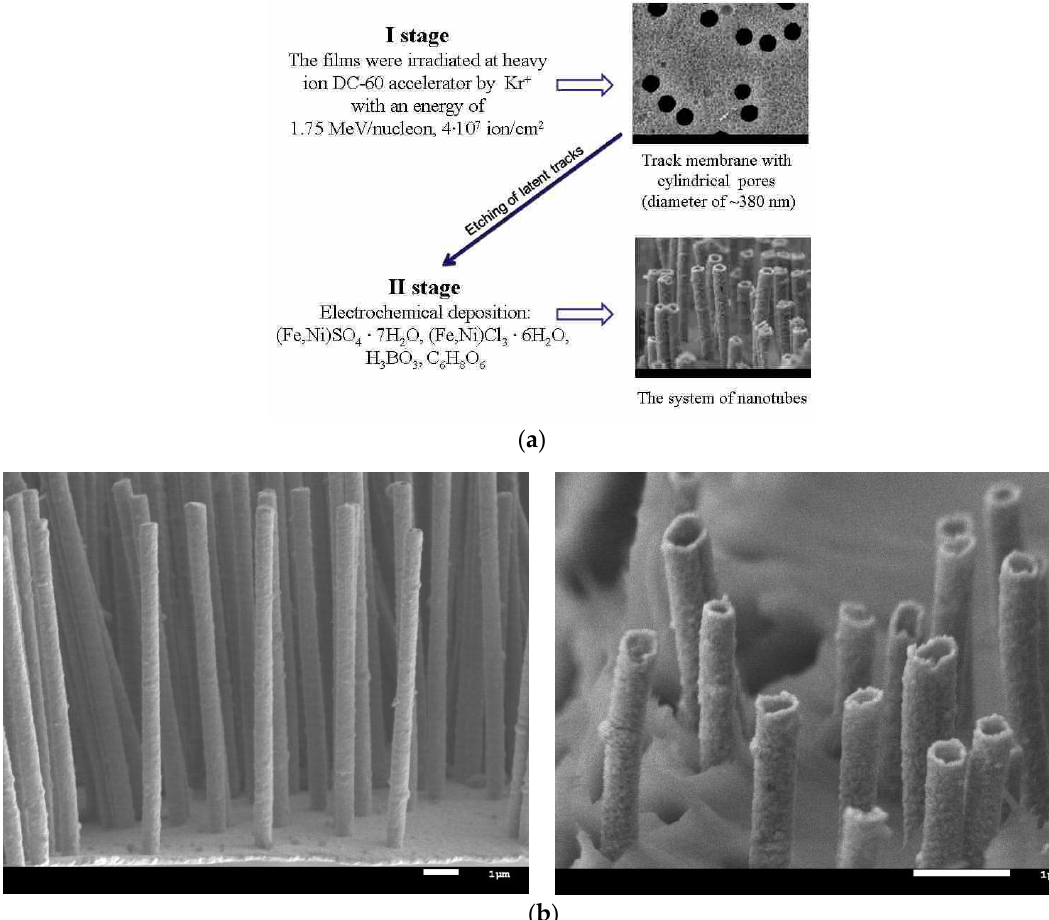
Figure 1. ( a ) Schematic representation of nanotubes synthesis; ( b ) SEM images of Fe 80 Ni 20 nanotubes.